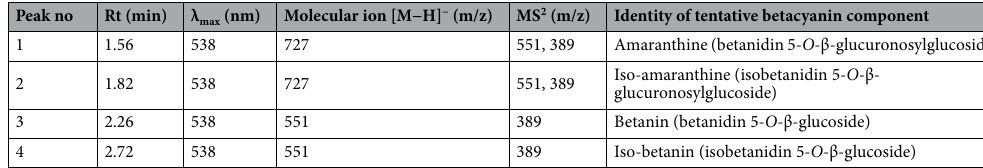
Table 1. Retention time (Rt), wavelengths of maximum absorption in the visible region (λ max ), mass spectral data and tentative identification of betacyanin component in four selected A. gangeticus leafy vegetables.